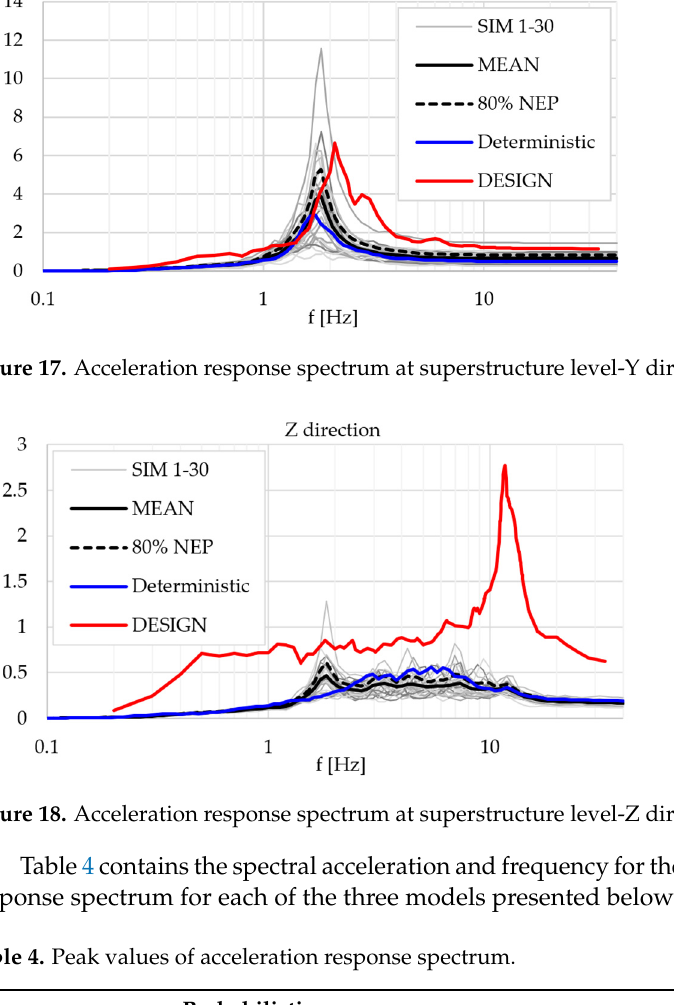
Figure 16. Acceleration response spectrum at superstructure level-X direction.